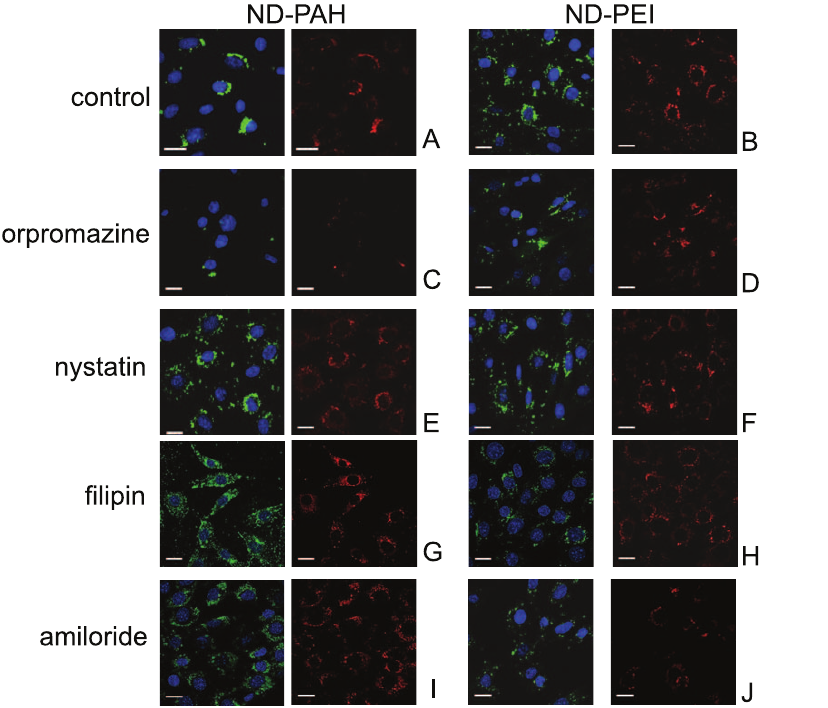
Figure 2. Study of the internalization pathways of siRNA-fND complexes in NIH/3T3 EWS-Fli1 cells, by fluorescence confocal microscopy. All the cells were incubated at 37 u C, with drugs inhibiting specific internalization pathways: (C, D) chlorpromazine, blocking the clathrin pathway; (E, F) nystatin or (G, H) filipin, blocking the caveola pathway and (I, J) amiloride hydrochloride, inhibiting macropinocytosis. (A, B): control cells incubated with cationic ND-siRNA complexes. Red channel: fNDs; green channel: FITC-labeled siRNA. Blue channel: DAPI labeling. Observations were carried out after the cells had been incubated for 4 h with 50 nM siRNA vectorized with either ND-PAH (left columns) or ND-PEI (right columns), at mass ratios of 1:25 and 1:75, respectively. Scale bars: 20 m m.